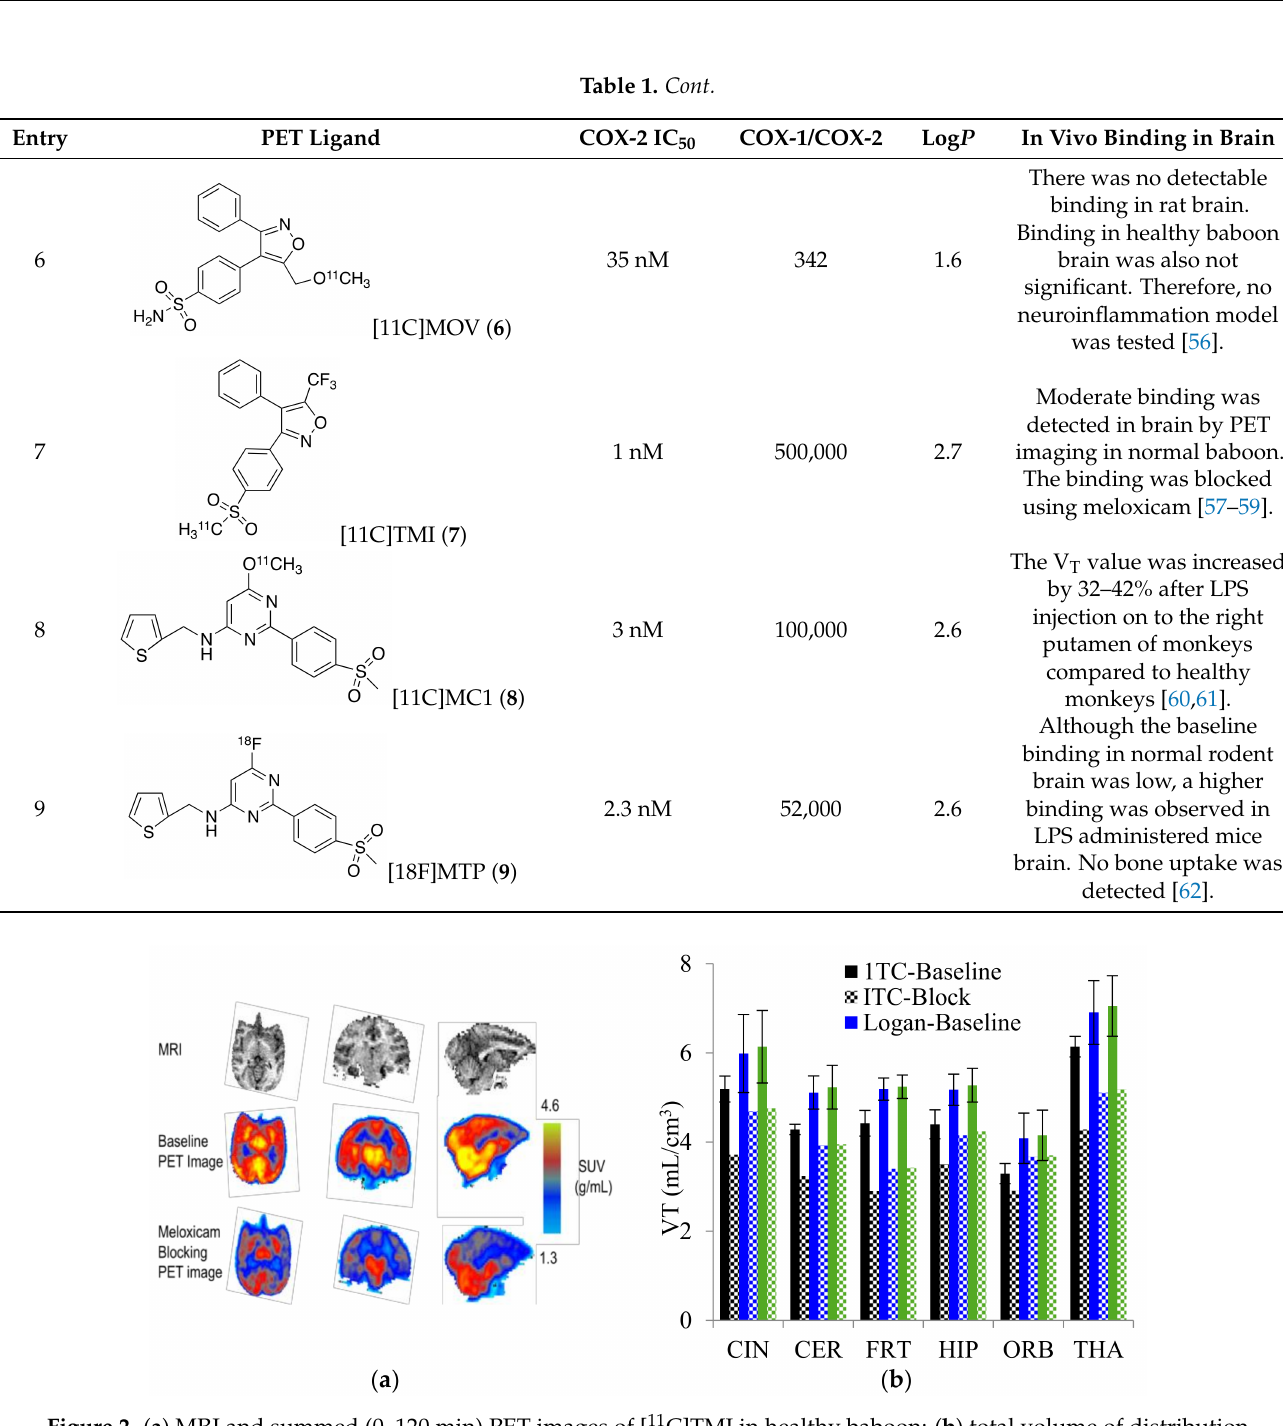
Figure 2. ( a ) MRI and summed (0–120 min) PET images of [ 11 C]TMI in healthy baboon: ( b ) total volume of distribution (VTs) in baboon brain, baseline and blocking, estimated using a one-tissue compartment (1TC), Logan plot and likelihood estimation in graphical analysis (LEGA) methods. CIN: cingulate cortex; CER: cerebellum; FRT: frontal cortex; HIP: hippocampus; ORB: orbital cortex; THA: